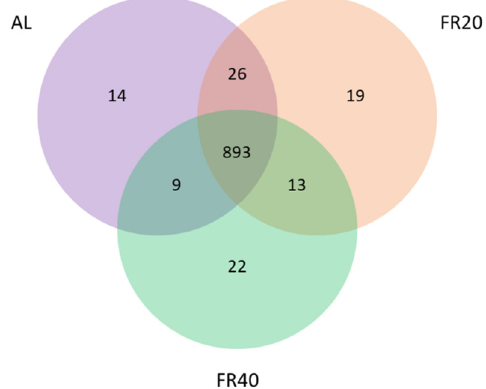
Figure 2. Venn diagram analysis of 996 OTU in the cecum of hens. Venn diagram showed 893 OTU among these three groups. A total of 14, 19, and 22 OTU were found in AL, FR20, and FR40 groups, respectively. Furthermore, 26 OTU were found in the AL and FR20, 13 OTU were found among the FR20 and FR40, and 9 OTU were found in the AL and FR40 groups. AL: ad libitum with basal diet; FR20: basal diet with 20% feed restriction; FR40: basal diet with 40% feed restriction.